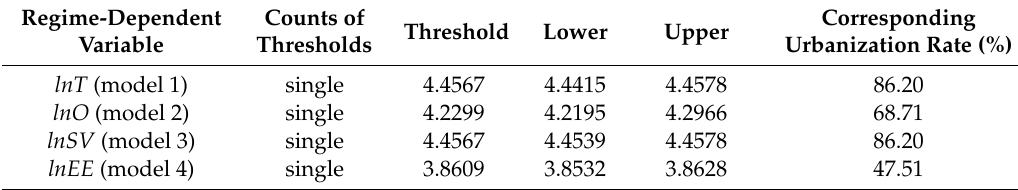
Figure 2. Likelihood ratio of each single threshold of urbanization for each model: ( a ) model 1, ( b ) model 2, ( c ) model 3 and ( d ) model 4. Table 4. Threshold results for each regime-dependent variable.